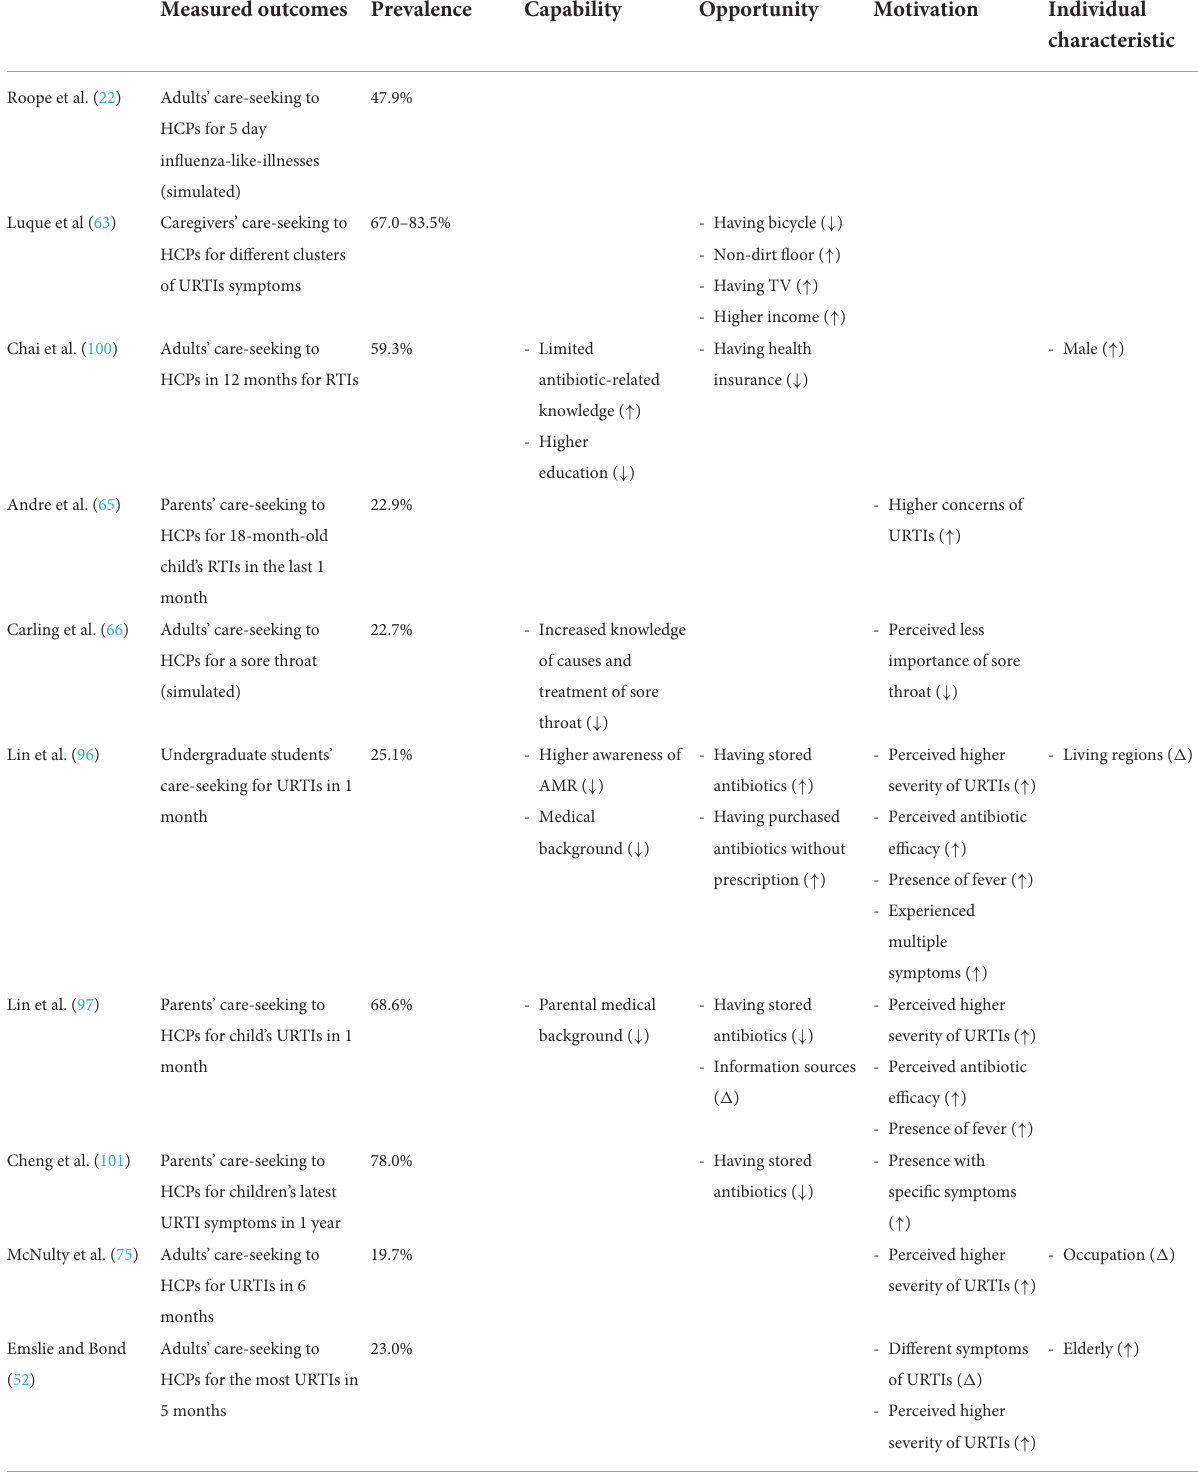
TABLE 2 The public’s care-seeking behaviors for URTIs and its influencing factors.